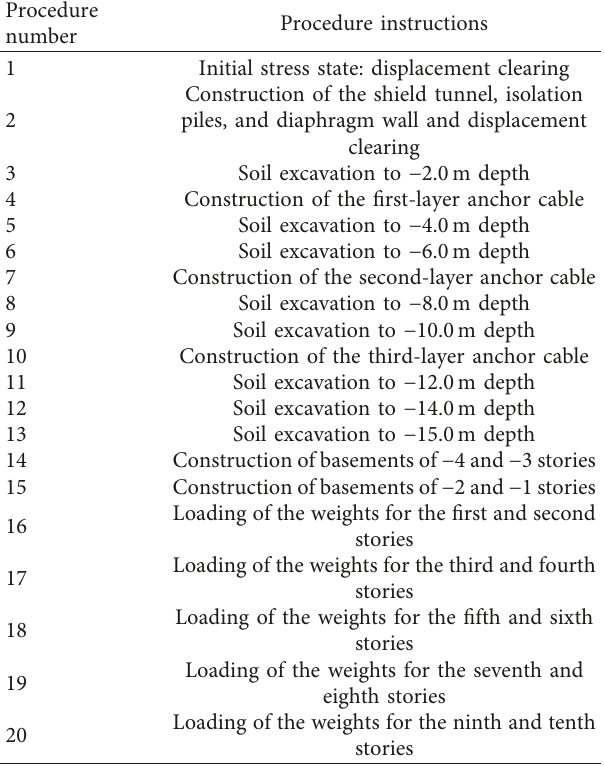
Table 7: Numerical simulation procedures.